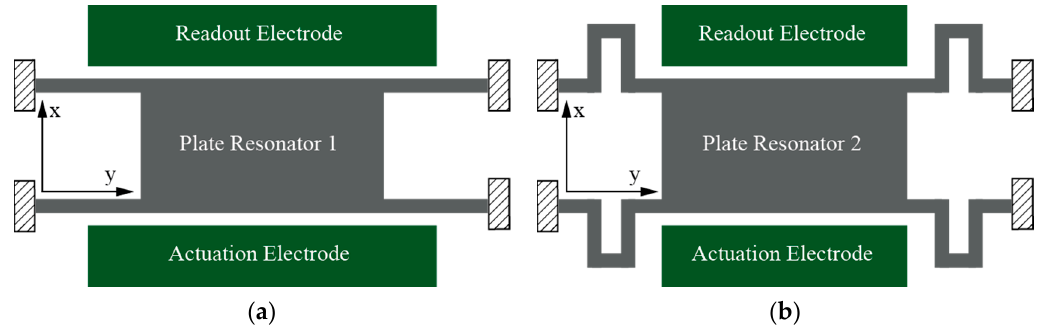
Figure 1. MEMS resonator schematic geometries for the fabricated and measured devices: ( a ) Plate resonator with straight anchors (PR1); ( b ) plate resonator with folded flexure anchors (PR2). Not to scale.